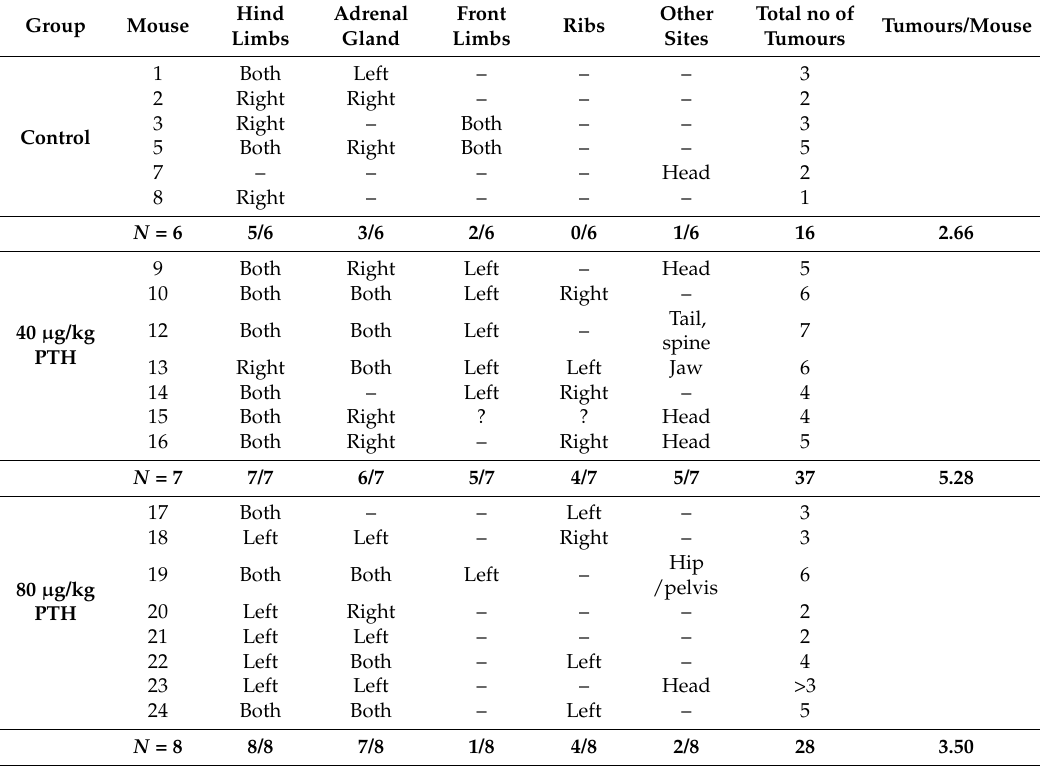
Figure 6. PTH pre-treatment affects development of tumours in an in vivo bone metastasis model. Twelve- week-old female BALB/c nude mice were treated with 40 µ g/kg, 80 µ g/kg PTH or PBS daily for 5 days before injection of tumour cells and monitoring of tumour growth by bioluminescence imaging. The number of detectable luciferase positive tumours was recorded for each mouse and is shown in three categories including: ( A ) the total number of tumours, ( B ) tumours detected in hind legs and ( C ) tumours detected in all sites except the hind legs. Data is presented as mean ± SEM and statistical analysis was performed using matched two-way ANOVA and multiple comparison post-test. * is 40 μg/kg PTH vs. PBS, ^ is 40 μg/kg PTH vs. 80 μg/kg PTH, + is 80 μg/kg PTH vs. PBS., A minimum of n = 6 animals per time point and treatment group were analyzed. Table 1. Overview of tumour distribution in PTH pre-treated animals. Overview of tumour distribution in skeletal and non-skeletal sites in animals treated with 40 μg/kg or 80 μg/kg PTH or PBS for 5 days followed by injection of DiD-labeled MDA-MB-231-tomato-luc2 cells. The number of detectable luciferase positive tumours was recorded for each mouse and the location is indicated in the table for hind limbs, front limbs, ribs, kidney and other sites. The mean tumour number/mouse in each group is indicated from one of three representative experiments.